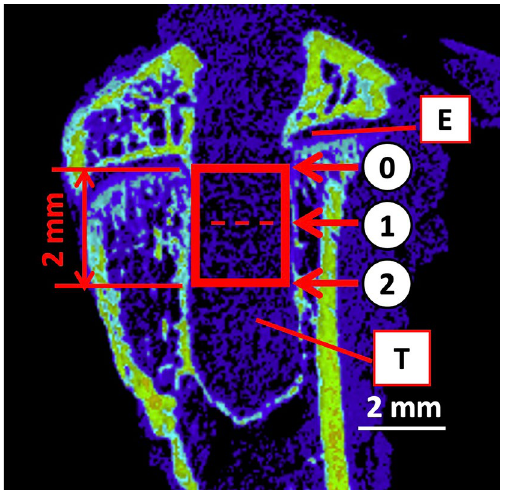
Figure 7. Measurement of bone mineral density at the graft–tibial tunnel interface. The definition of the measurement area of bone mineral density. The CT image shows slices along the long axis of the tibial tunnel. Bone mineral density at the top, middle, and bottom of a region 2 mm distal to the tibial epiphyseal plate was measured. The major and minor tunnel diameters were measured at three cross-sections, namely, the upper (0), middle (1), and lower (2) ends of the region 2 mm distal to the growth cartilage (red square) in the femur–graft– tibia complex. The data on day 0 after anterior cruciate ligament reconstruction were used to determine the baseline diameter of the hole drilled. CT computed tomography, E epiphysis, T tunnel.